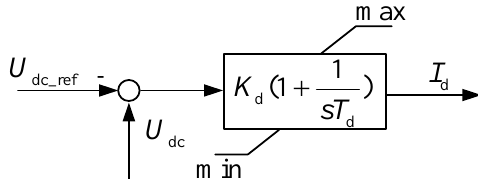
Figure 5. Steady-state operation control module of inverter.